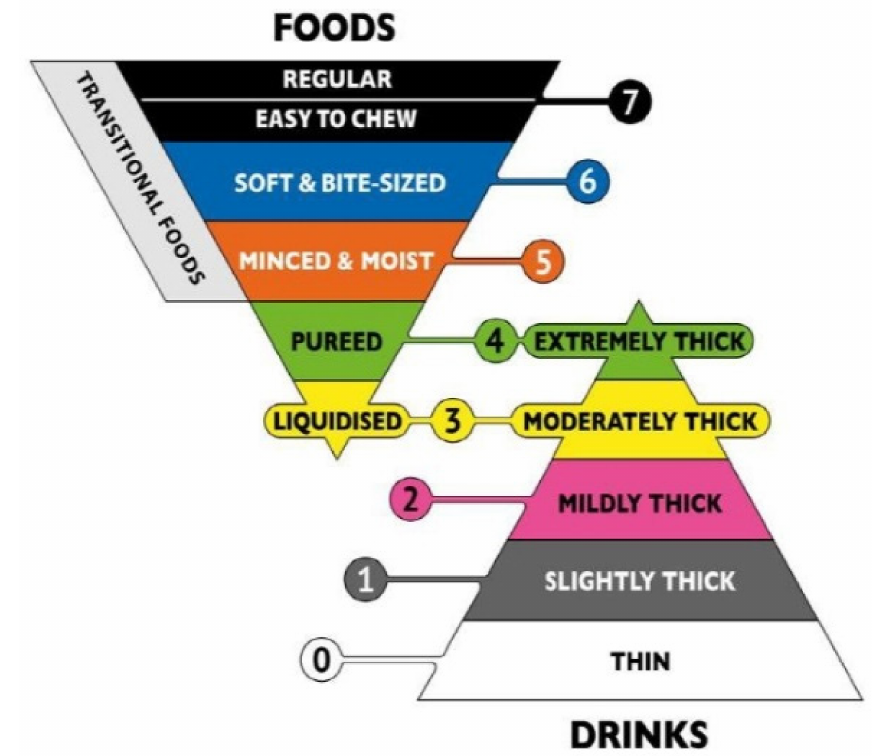
Figure 3. The IDDSI Framework for the TM food and thickened liquids used with dysphagic individ- uals from all age groups, in all healthcare facilities and of all cultures [122]. Note. 0: thin; 1: slightly thick; 2: slightly thick; 3: liquidized/moderately thick; 4: pur é ed/extremely thick; 5: minced and moist; 6: soft and bite-sized; 7: easy to